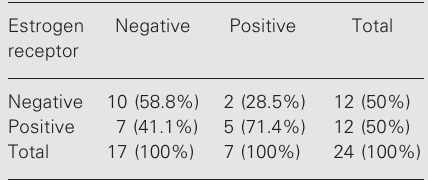
Table 2. Association between human papillomavi- rus (HPV) and estrogen receptors in the normal epithelium of the uterine